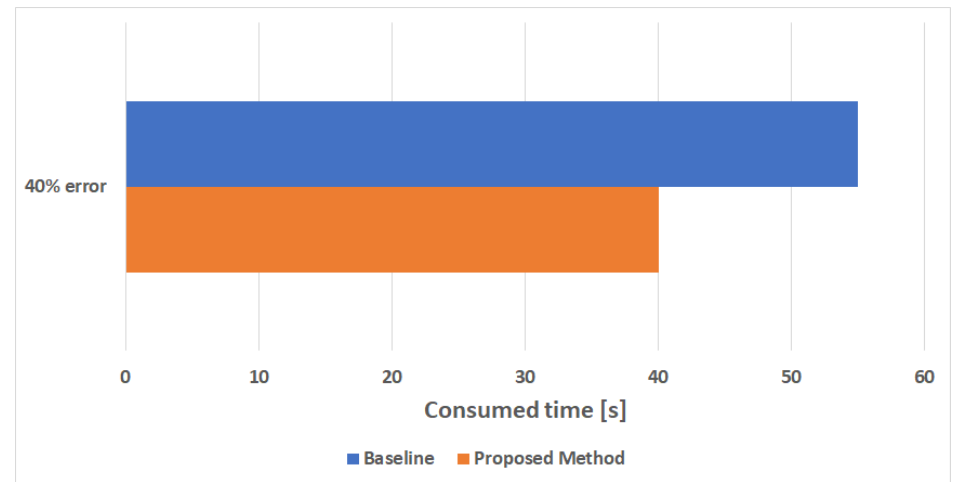
Figure 26. Load Testing—with 40% error.